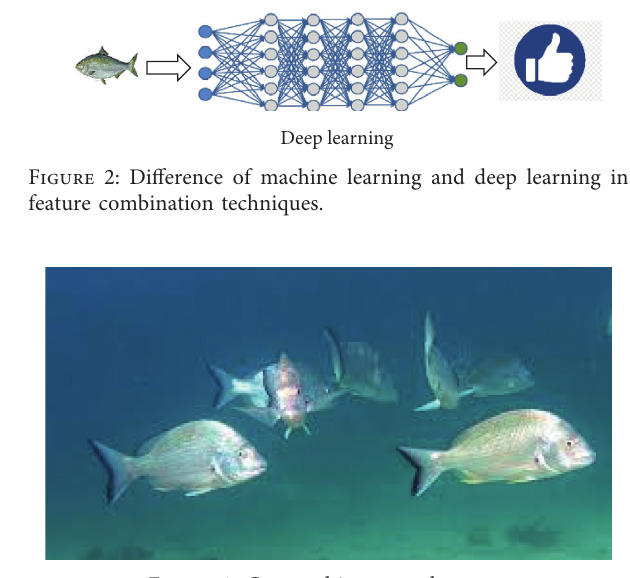
Figure 3: Captured image underwater.